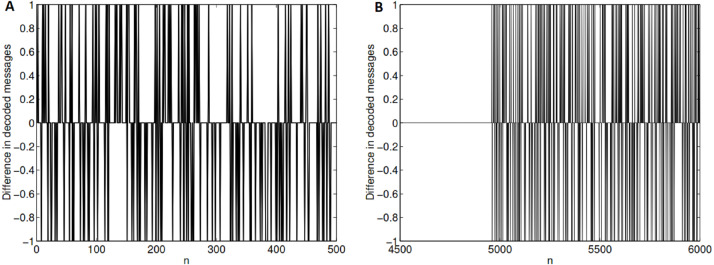
Effect of noise on GLS-coding.(A) The first bit of the compressed file is flipped. The decoded message is very different from the actual intended message. (B) The middle bit (bit no. 3610) of the compressed file is flipped. The first 5,000 bits are decoded without error and the remaining 5,000 bits show lots of decoding error. (p = 0.2, N = 10, 000, Compressed file size =7,220 bits). In both cases, only part of the difference is shown.